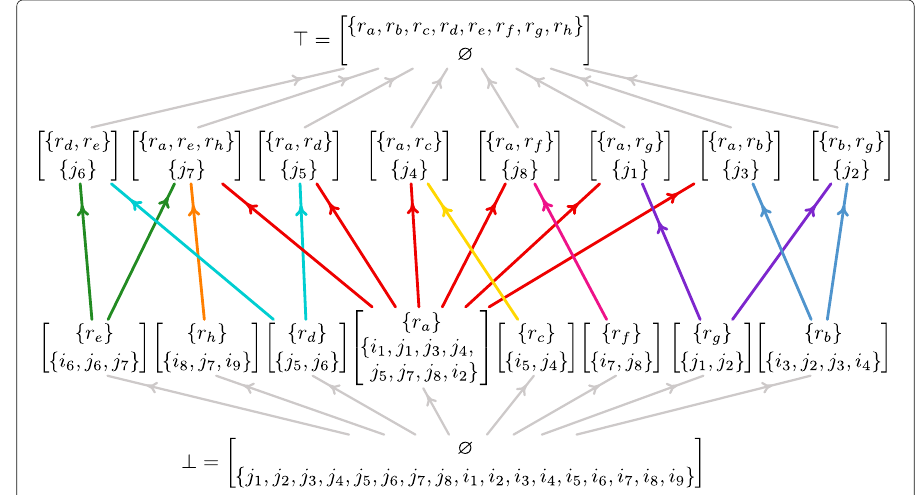
Fig. 3 Road-junction Galois lattice associated to the colourized notional urban street network introduced in Fig. 1 with the labelling chosen in Fig. 2. This Galois lattice is obtained by applying the Formal Concept Analysis (FCA) paradigm to the incidence relation I whose chart representation is given in Table 1. This construction is one-to-one. A Galois lattice is an algebraic structure that underlies a partial order relation (cid:2) and two algebraic operators, a join operator ∨ and a meet operator ∧ . The partial order relation can be interpreted as an extended logical imply relation → . The arrows in the diagram inherit this interpretation. For FCA lattices, each element is a pair of sets [ R , J ] where R is a set of objects and J a set of attributes. Here the roads r ∗ are the objects whose attributes are junctions j ∗ and impasses i ∗ (see Table 1). Because the roads r ∗ do not cross to each others more than once, the Galois lattice takes an intuitive two-layer form. Indeed, the join-irreducible elements [ { r ∗ } , J ] and the meet-irreducible elements [ R , { j ∗ } ] readily identify themselves with their road r ∗ and their junctions j ∗ , respectively. So, the roads r ∗ and the junctions j ∗ immediately form, respectively, the lower and upper nontrivial layers of the Galois lattice. This also gives meaningful and intuitive interpretations to the partial order relation (cid:2) and to the operators ∨ and ∧ : r a (cid:2) j 7 (or r a → j 7 ) reads “road r a passes through junction j 7 ” or “junction j 7 is along road r a ”; r a ∨ r b = j 3 reads “roads r a and r b join at junction